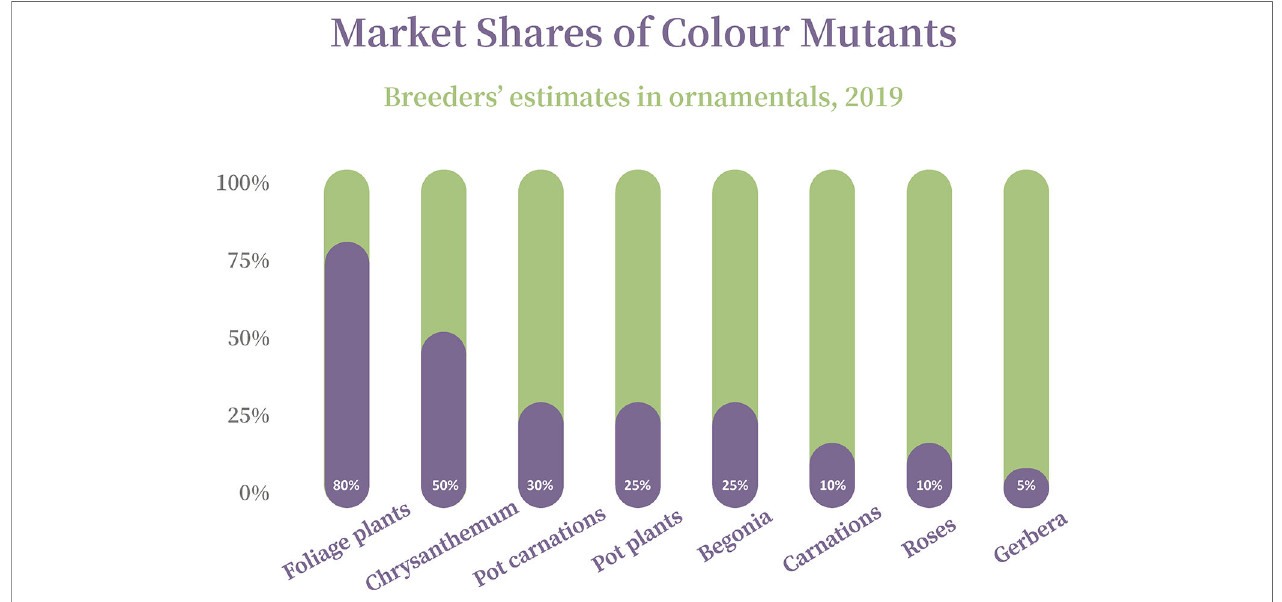
FIGURE 4 | Market shares of color mutants in ornamentals as estimated by breeders,